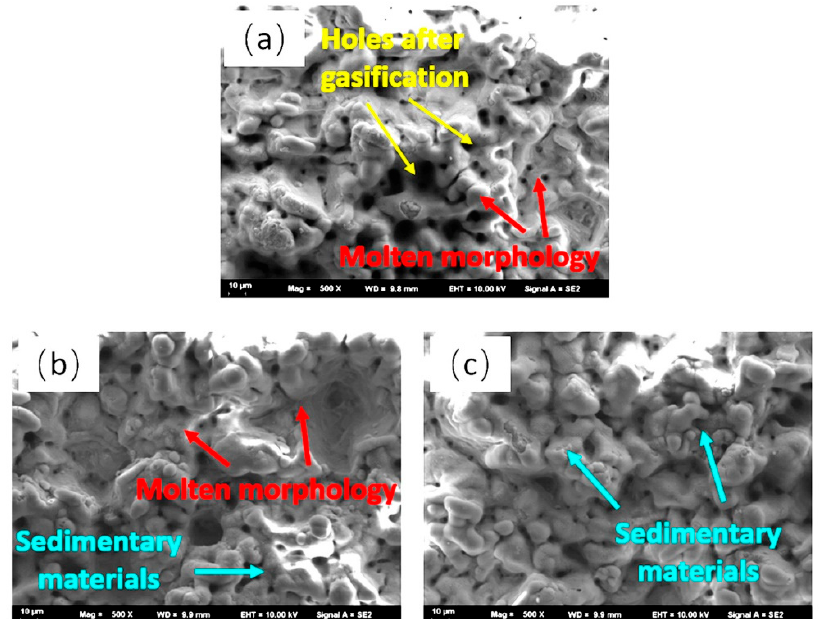
Figure 8. Surface microstructure after laser milling with different numbers of milling processes: ( a ) three; ( b ) five; ( c ) nine times.